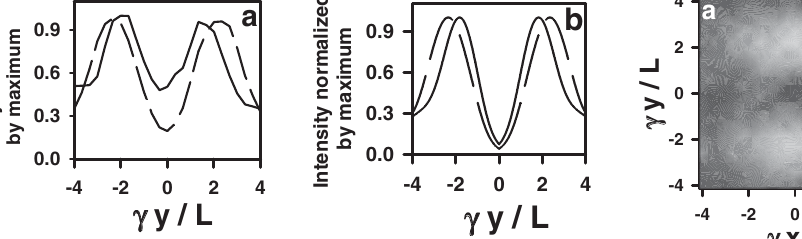
FIG. 20. Three-dimensional spatial distribution of ODR verti- cal polarization component measured without (a) and with (b) the lens and with 550 nm optical